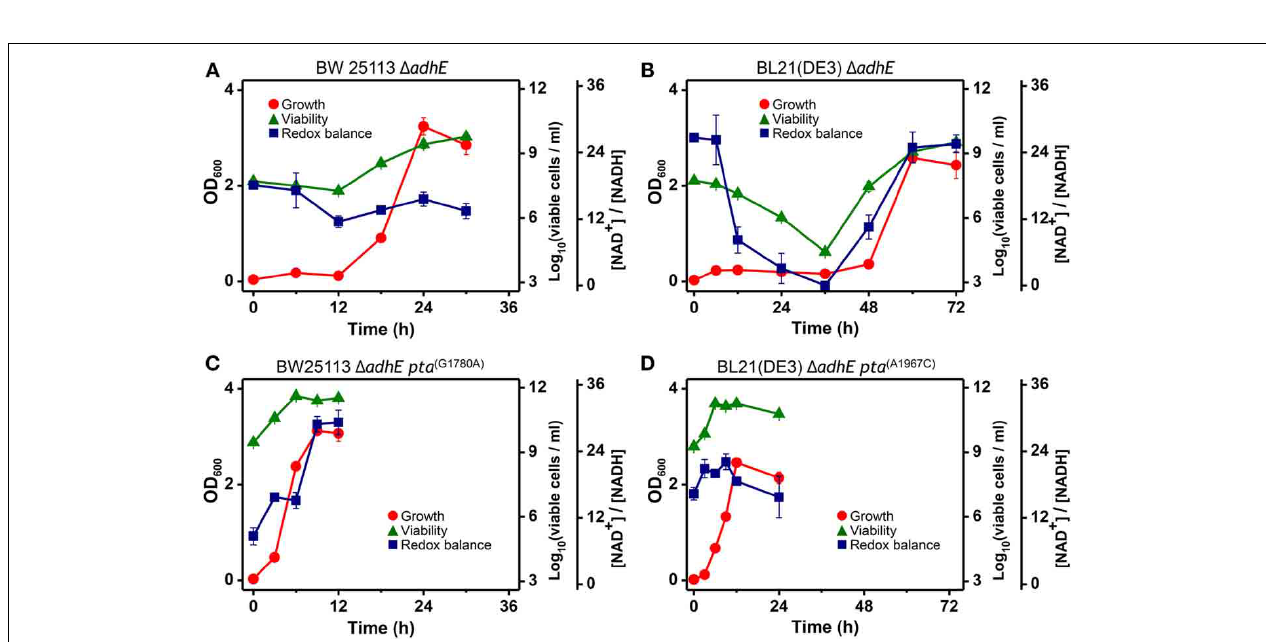
FIGURE 9 | Anaerobic growth of E. coli K-12 (cid:2) adhE and B (cid:2) adhE cells when various carbon sources with different oxidized states were used. (A) D-Gluconate, (B) D-glucose, (C) D-fructose, and (D) D-mannitol were respectively added to the fermentation medium as a major carbon source.